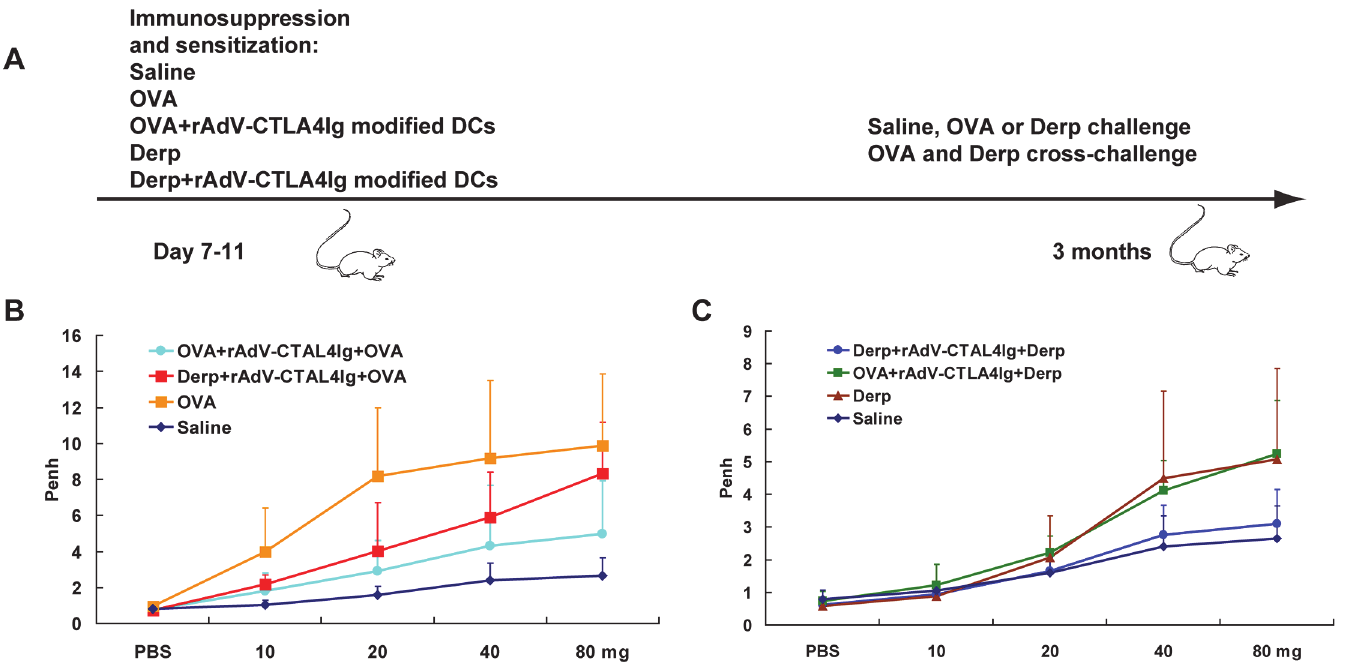
Fig 3. Specificity assessment. To evaluate whether the persistent immune tolerance was allergen-specific, the neonatal mice were treated with OVA +rAdV-CTLA4Ig-modified DCs or Derp+rAdV-CTLA4Ig-modified DCs, 3 months later, the specificity of the therapeutic strategy was assessed by allergen cross challenge. Each group contains 10 mice. Saline, OVA and Derp represented mice treated, sensitized and challenged by saline, OVA and Derp respectively. OVA+rAdV-CTLA4Ig+OVA represented mice treated with rAdV-CTLA4Ig, sensitized by OVA and challenged by OVA. Derp+rAdV-CTLA4Ig +OVA represented mice treated with rAdV-CTLA4Ig, sensitized by Derp and challenged by OVA. Derp+rAdV-CTLA4Ig+Derp represented mice treated with rAdV-CTLA4Ig, sensitized by Derp and challenged by Derp. OVA+rAdV-CTLA4Ig+Derp represented mice treated with rAdV-CTLA4Ig, sensitized by OVA and challenged by Derp. A, the regimen of sensitization, challenge, and treatment in specificity assessment. B, airway reactivity testing of OVA-sensitized mice challenged by OVA or Derp. C, airway reactivity testing of Derp-sensitized mice challenged with Derp or OVA.